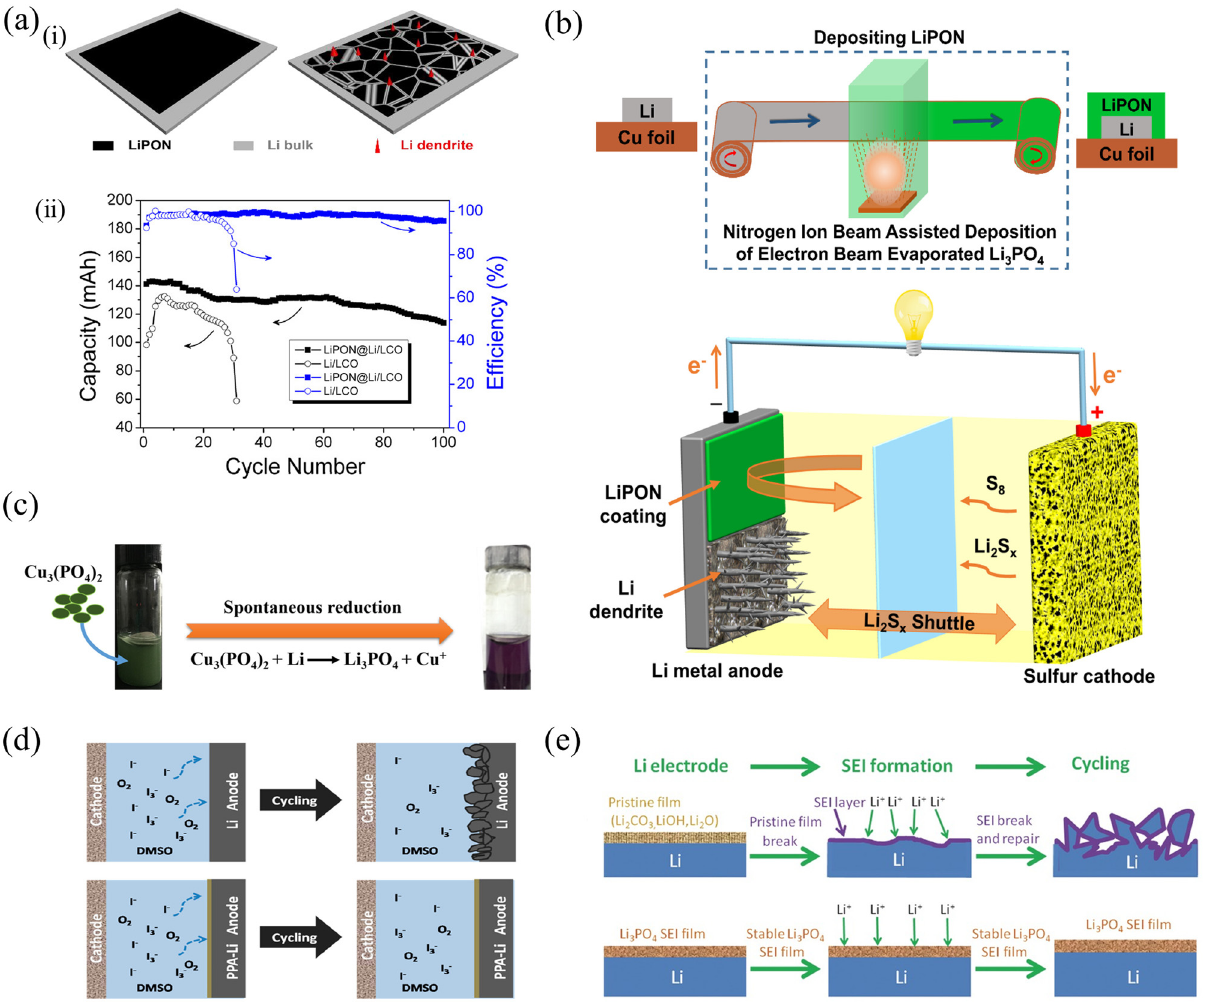
Figure 6: ( a ) Schematic diagrams of LiPON@Li anodes in pouch cells with low - energy density and ultrahigh energy density after cycles ( i ) and capacity of cells and e ffi ciencies as a function of cycle number at 0.1 C ( ii ) , reprinted with permission from ref. [ 73 ] ; ( b ) schematic diagrams of the mass production of LiPON - coated Li metal foils by using a continuous roll - to - roll system and the performance of a LiPON - coated Li metal anode in Li – S battery con fi gurations, reprinted with permission from ref. [ 74 ] ; ( c ) the process for the fabrication of the Li 3 PO 4 – Li anode, reprinted with permission from ref. [ 75 ] ; ( d ) schematic structures of the Li – O 2 Cells with LiI/LiNO 3 /DMSO electrolyte of Li anode and PPA – Li anode, reprinted with permission from ref. [ 76 ] ; ( e ) schematics of the general Li metal and Li 3 PO 4 - modi fi ed Li metal anodes during SEI formation and cycling, reprinted with permission from ref. [ 77 ]